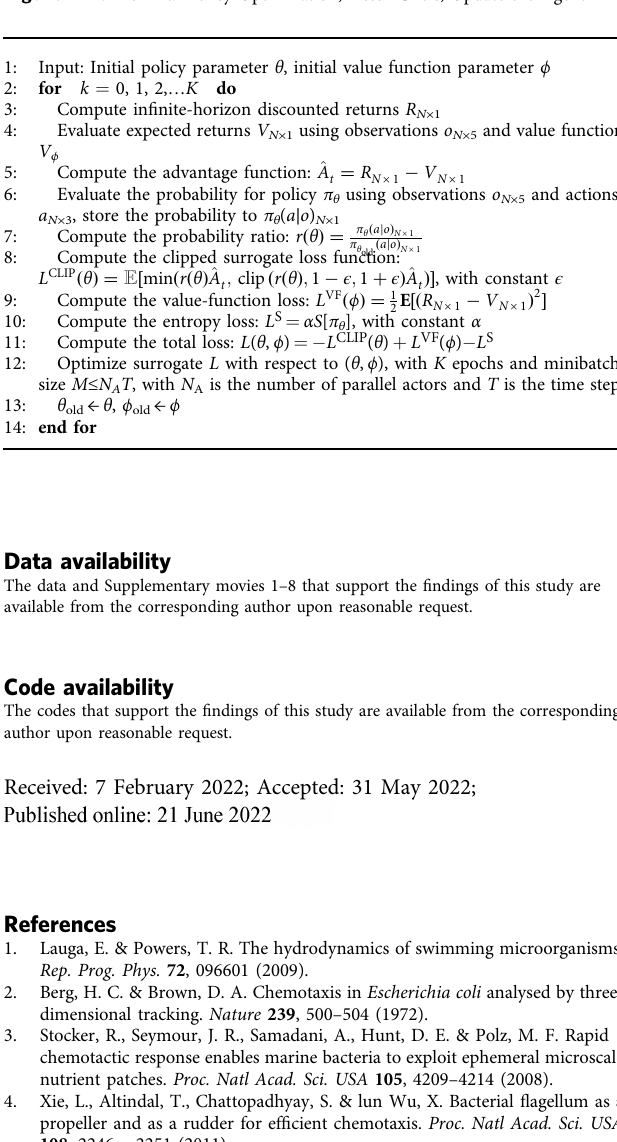
Algorithm 2 . Proximal Policy Optimization, Actor-Critic, Update the